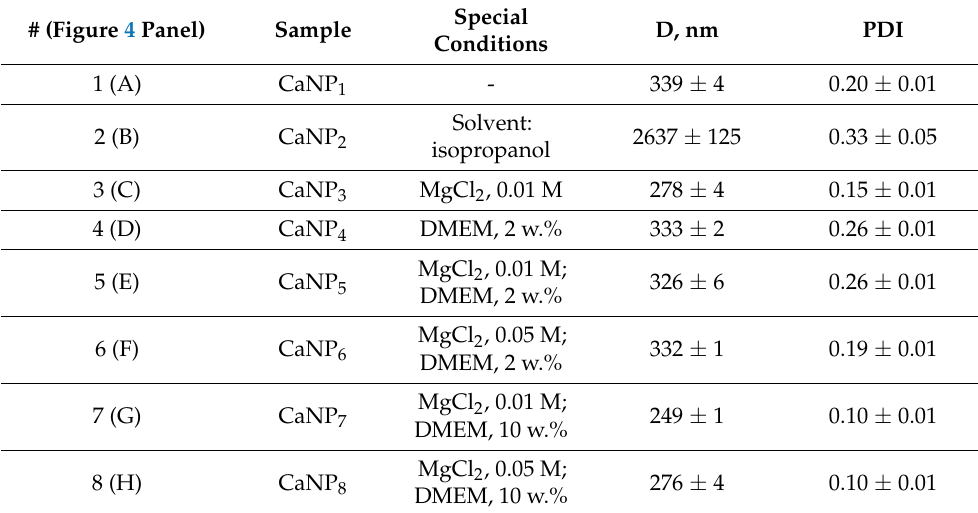
Table 1. The influence of changing a single parameter in the CaNP 1 fabrication